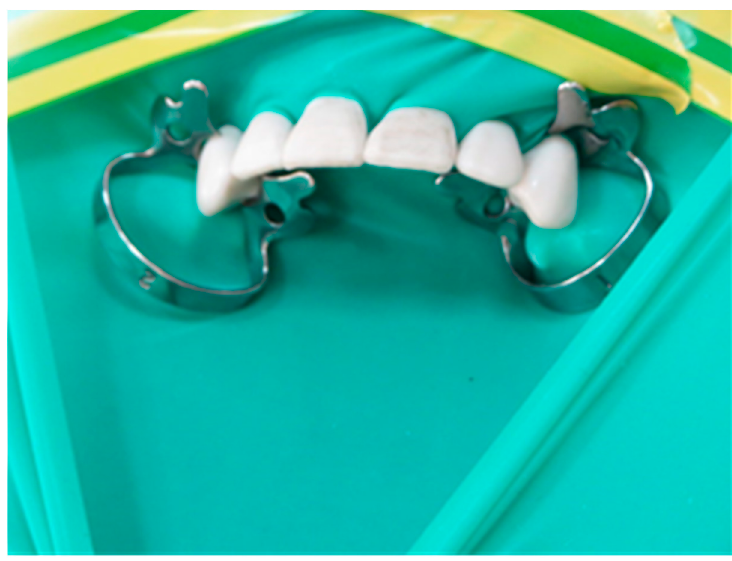
Int. J. Environ. Res. Public Health 2021 , 18 , x Figure 1. Upper anterior quadrant isolation by the rubber dam. Figure 1. Upper anterior quadrant isolation by the rubber dam.